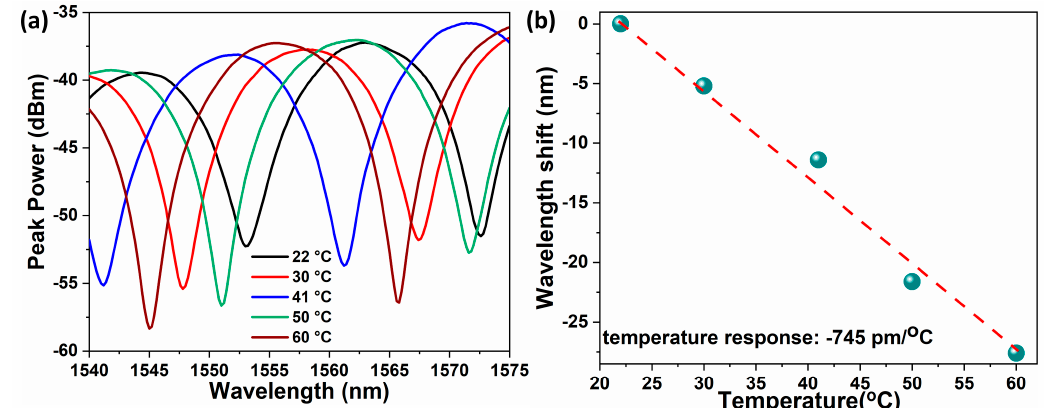
Figure 8. Response of the spectral minima of the FPI sensor to temperature variations ( a ) and corresponding wavelength shift of a specific spectral minimum ( b ).